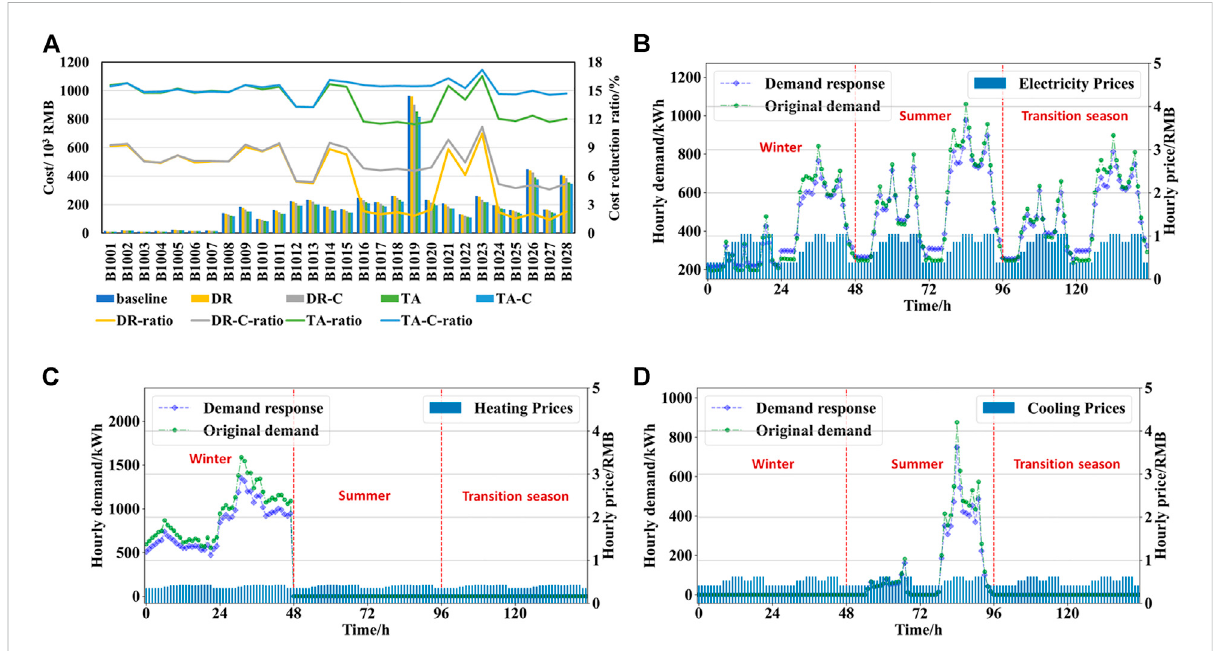
FIGURE 9 Theresultsofdemandresponseofuses.Figure (A) showsthetotalannualcostandcostreductionratiosforeachuserunderdifferentscenarios. The total electricity, heating, and cooling demand response of users on typical days are shown in (B – D) .